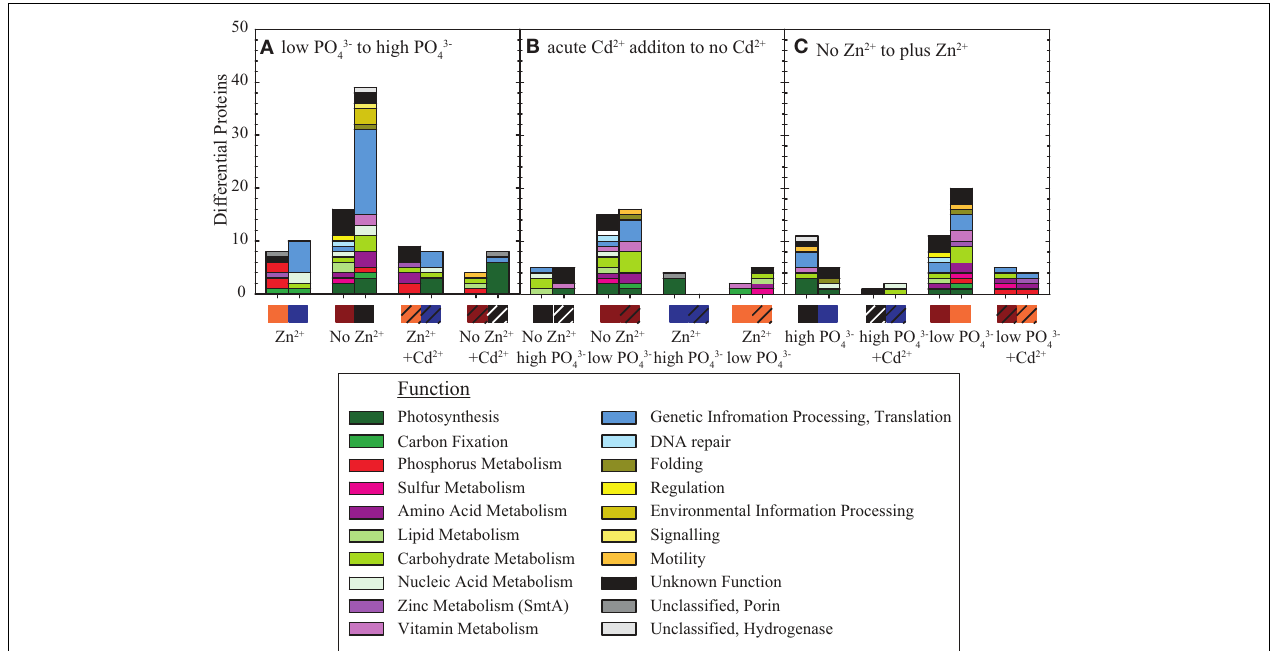
FIGURE 5 | Number of proteins two-fold or more abundant in pairwise comparisons, with other matix treatments equivalent (color bar on x-axis corresponds with Figure 2 design), with protein bars colored by KEGG function. (A) Proteins more abundant with scarce PO 43 − relative to replete conditions and vice versa (right and left bars, respectively). (B) Proteins more abundant with short-term Cd addition relative to no Cd added and vice versa (right and left bars, respectively). (C) Proteins more